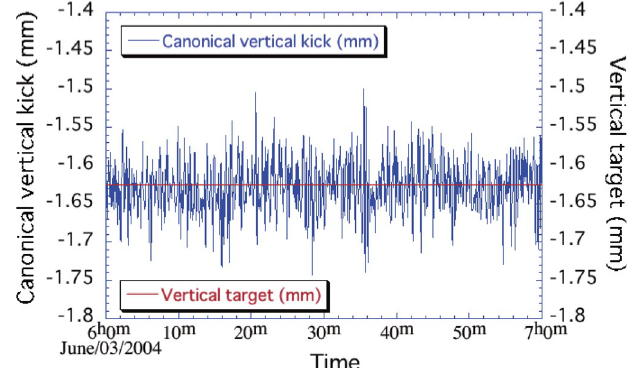
FIG. 2. (Color) Fluctuation of the canonical vertical kick